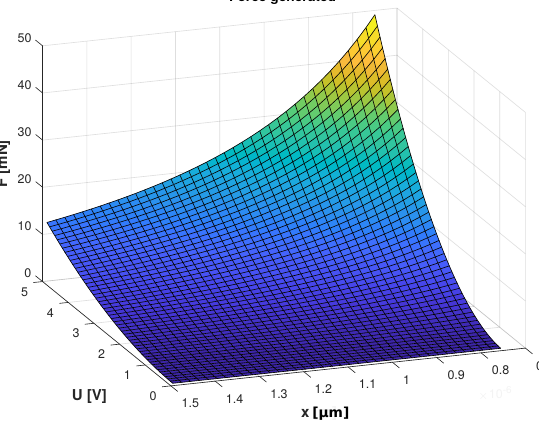
Figure 5. Force generated versus voltage and distance between two